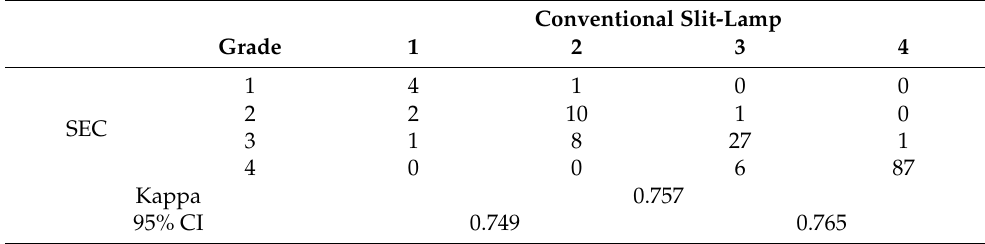
Table 3. Reproducibility of the Van-Herick Plus grade.